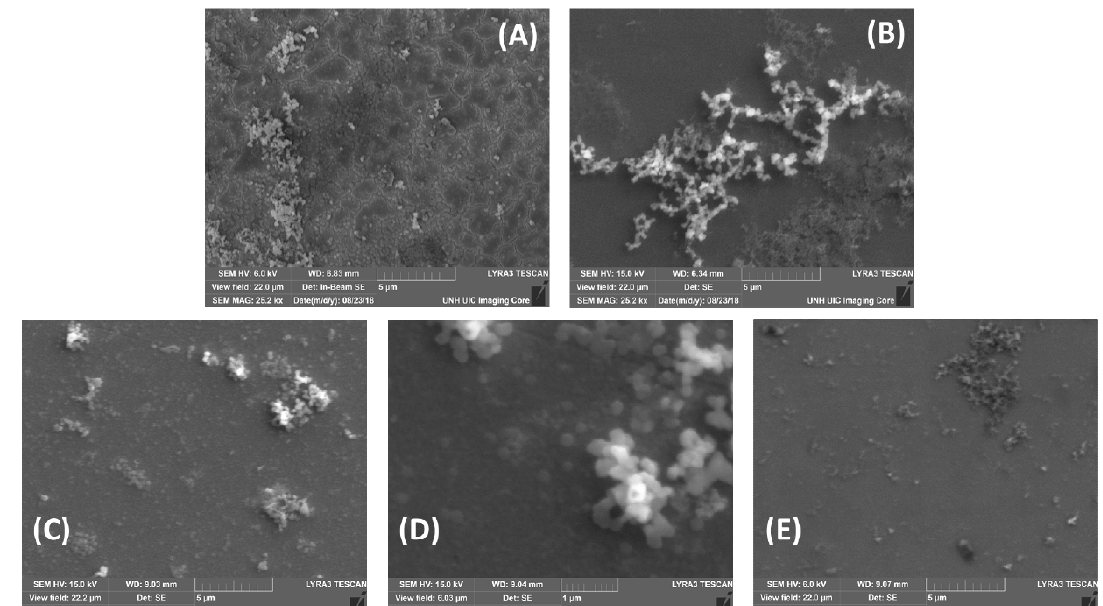
Figure 6. Scanning electron microscopy (SEM) images of ( A ) nickel, ( B ) nickel oxide, ( C ) nickel oxide after phosphate buffer saline (PBS), ( D ), zoomed in on the particle of nickel oxide after PBS, and ( E ) nickel oxide after arginine. There is less nickel oxide content and thickness observed after arginine; this is comparable to original nickel graphs. All images are at 25 k× magnification except ( D ).